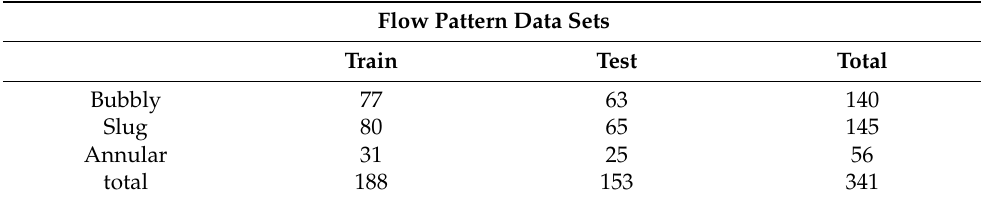
Table 6. The number of samples of different flow patterns.